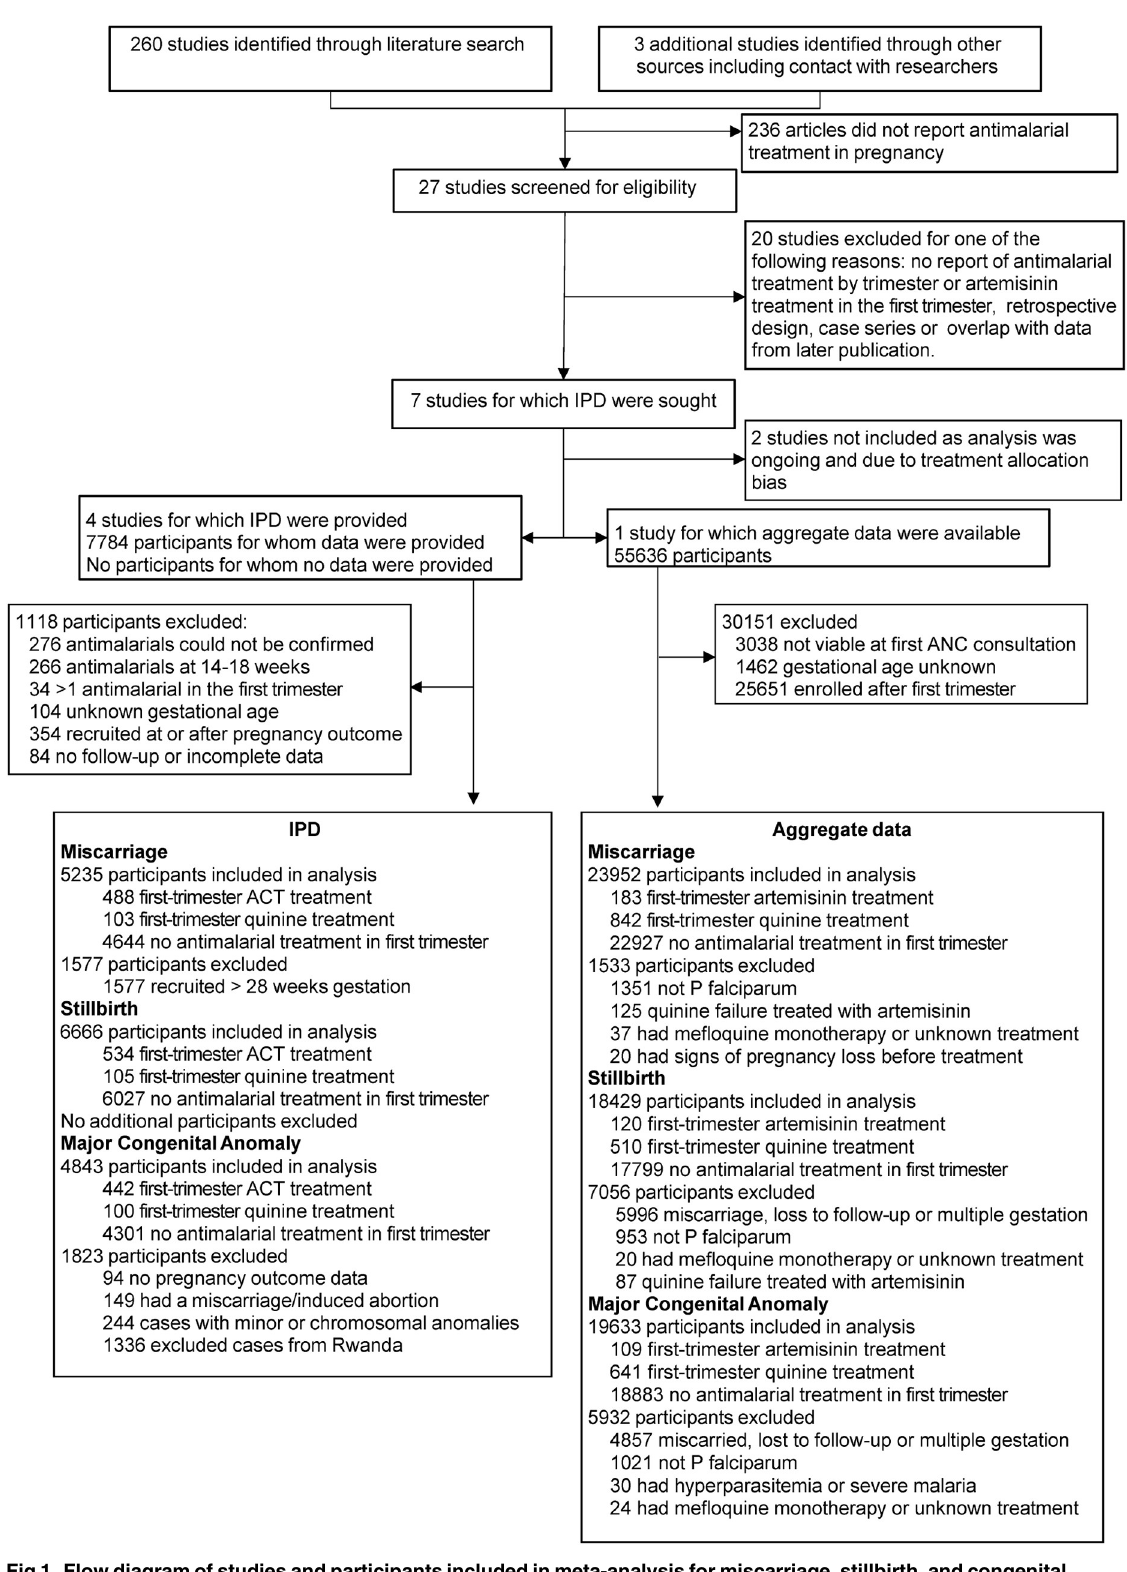
PLOS Medicine| https://doi.org/10.1371/journal.pmed.1002290 May 2,